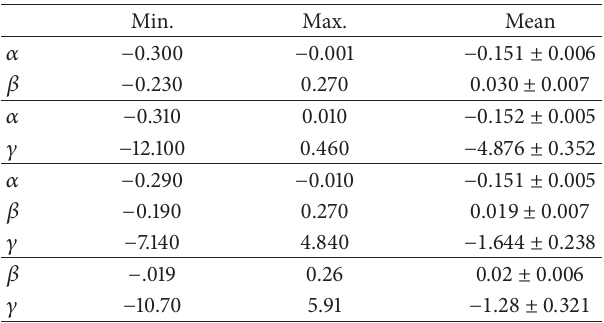
Table 2: Summary of minimum, maximum, and mean values of the obtained coefficients ( 𝛼 , 𝛽 ), ( 𝛼 , 𝛾 ), ( 𝛼 , 𝛽 , 𝛾 ), and ( 𝛽 , 𝛾 ).